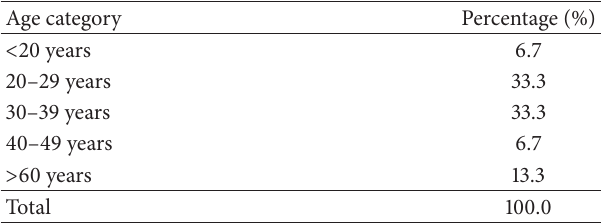
Table 1: Age structure of pig producer respondents ( 𝑁 = 90 ).